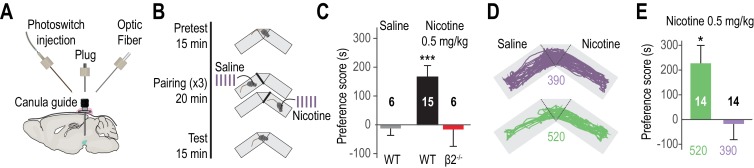
Reversibly disrupting nicotine preference.(A) Experimental design of the opto-fluidic device for opto-pharmacology experiments in freely-moving mice. The cannula guide is chronically implanted above the VTA and is used for both photoswitch and light delivery. (B) Nicotine-place preference protocol. Drug-free pretest (15 min) was followed by 3 consecutive days of pairing, which consisted in morning and evening saline and nicotine (0.5 mg/kg) conditioning sessions (20 min). For experiments using LinAChRs, mice were injected with the photoswitch in the morning and received light (390 or 520 nm, 2 s flashes at 0.1 Hz) in both pairing chambers. On day 5, mice were placed in the central chamber (no drug, no light) and were allowed to freely explore the environment. (C) Mean preference score (ps) for WT mice conditioned with saline (grey, n = 6, ps = −12.8 ± 24.0 s, p=0.69) and with nicotine (black, n = 15, ps = 165.9 ± 39.6 s, p=6.1e−04), and for β2-/- mice conditioned with nicotine (red, n = 6, ps = −16.2 ± 58.7 s, p=0.44). (D) Representative trajectories of β2E61C-transduced and MAHoCh-treated mice conditioned with nicotine, under 390 (purple) and 520 nm light (green). (E) Mean preference for nicotine is abolished under 390 nm (purple, ps = −17.6 ± 63.8 s, p=0.80) and restored under 520 nm light (green, ps = 227.3 ± 72.1 s, p=0.015). Two groups of 7 mice were pooled. All values represent mean ± SEM.10.7554/eLife.37487.017Figure 5—source data 1.Source data for Figure 5C,E.